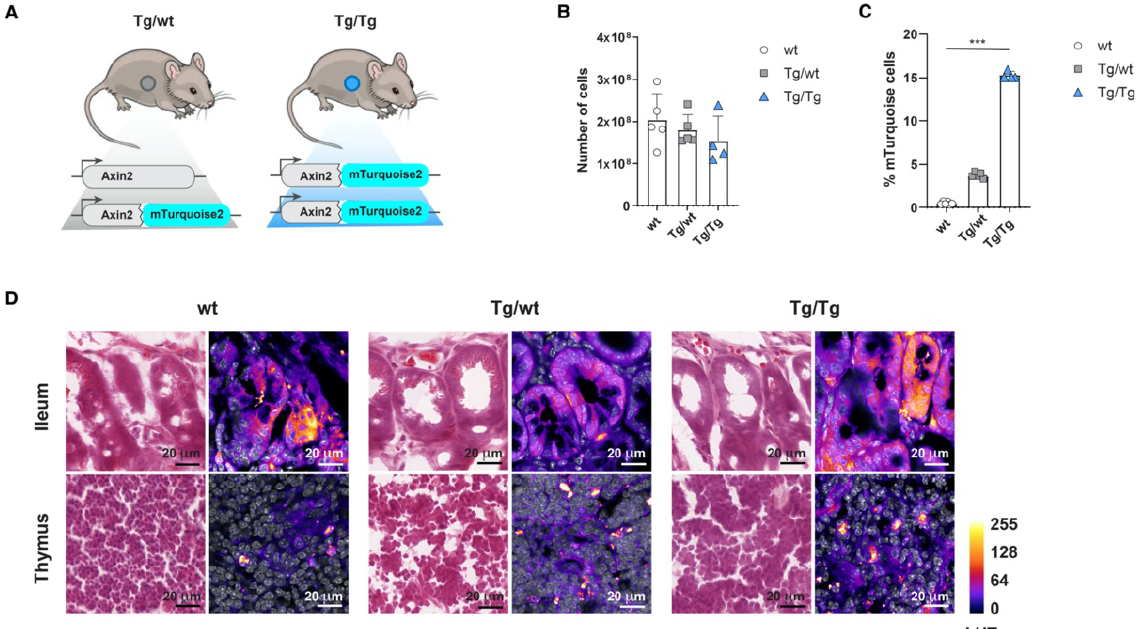
Figure 1. Axin2-mTurquoise2 reporter expression in the thymus and intestine. Axin2-mTurquoise2 reporter expression through FACS and cryosection confocal analysis in the canonical Wnt organs, the thymus and the ileum of the intestine. ( A ) Schematic representation of the Axin2-mTurquoise2 reporter mice, in which mTurquoise2 was targeted into one (Tg/wt) or both (Tg/Tg) of the alleles of the Wnt target gene Axin2 . Tg/Tg mice in which both Axin2 alleles were targeted with the mTurquoise2 gene were thereby rendered Axin2 knock-out null mutants. ( B ) Total thymocyte cell numbers ob- tained from wild-type (wt), heterozygous (Tg/wt) and homozygous (Tg/Tg) Axin2-mTurquoise2 steady-state mice. Data represent results for five wild-type control mice (wt), five heterozygous Axin2- mTurquoise2 mice (Tg/wt) and four homozygous Axin2-mTurquoise2 mice (Tg/Tg) from two inde- pendent experiments. Error bars represent standard errors of the means (SEMs). ( C ) Quantification of the frequencies of mTurquise2 from total thymocytes of Axin2-mTurquoise2 mice. Data represent results for five wild-type control mice (wt), five heterozygous Axin2-mTurquoise2 mice (Tg/wt) and four homozygous Axin2-mTurquoise2 mice (Tg/Tg) from two independent experiments. Error bars represent SEMs. *** p < 0.001 (ANOVA test). ( D ) H&E staining (first column of each genotype) and immunofluorescence analysis (second column of each genotype) of mTurquoise2 activity in Axin2-mTurquoise2 thymuses and ilea. Confocal images were captured with a Leica SP5, using identical settings, and processed in ImageJ. Nuclear staining with TO-PRO-3 is shown in grayscale, while differences in mTurquoise2 activity correspond to Fire LUT intensity. Imaged at 100 × ; scalebars are set at 20 µ